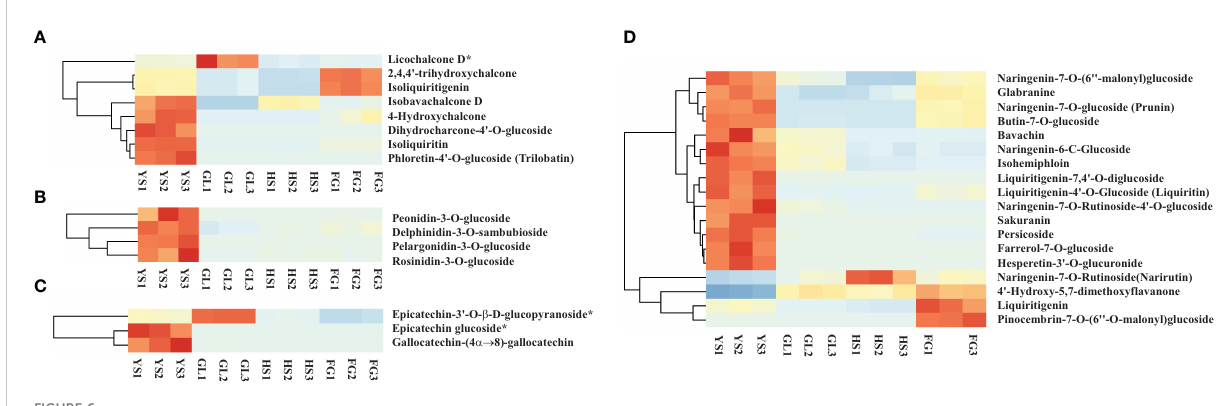
FIGURE 6 Heatmap of selected differentially accumulated metabolites. (A) chalcones; (B) anthocyanins; (C) fl avanols; (D) dihydro fl avones in P. thomsonii and P. lobata . HS, FG, GL, P. thomsonii varieties; YS, P. lobata